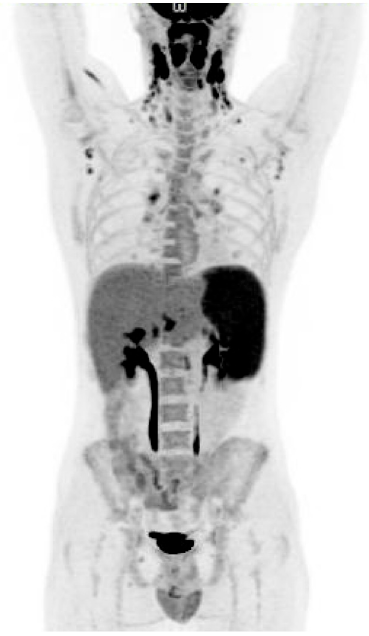
Figure 1. A 21-year-old man presented with 6 weeks of unexplained fever, pharyngitis, enlarged cervical neck lymph nodes, night sweats and severe fatigue. The patient was treated as an outpatient with antibiotics for acute tonsillitis twice without any improvement. He had persistent daily fever and a 6 kg unintentional weight loss. No significant past medical history. Epstein-Barr virus (EBV) and Cytomegalovirus (CMV) titers drawn one week after debut of symptoms were negative. Three months before presenting with symptoms the patient had been travelling in South East Asia for 3.5 months. He had not been sick during his travel abroad. Physical examination was significant for lymphadenopathy at the cervical neck. No splenomegaly was noted. At admission white blood cells was 13.0 ˆ 10 9 /L (normal range: 3.5–8.8 ˆ 10 9 /L) with 10.0 ˆ 10 9 /L lymphocytes (normal range: 1.0–3.5 ˆ 10 9 /L). Alanine aminotransferase (ALT) was elevated at 104 U/L (normal range: 10–70 U/L) and Lactate dehydrogenase (LDH) was elevated at 939 U/L (normal range: 105–205 U/L). Due to concern of malignant lymphoma an 18 F-FDG PET/CT was performed (Figure 1). The scan revealed pathologically 18 F-FDG uptake in enlarged lymph nodes in the bilateral regions of neck, axillas, lung hili, and in an enlarged spleen (18 cm). Findings were suspicious for malignant lymphoma. A lymph node biopsy was